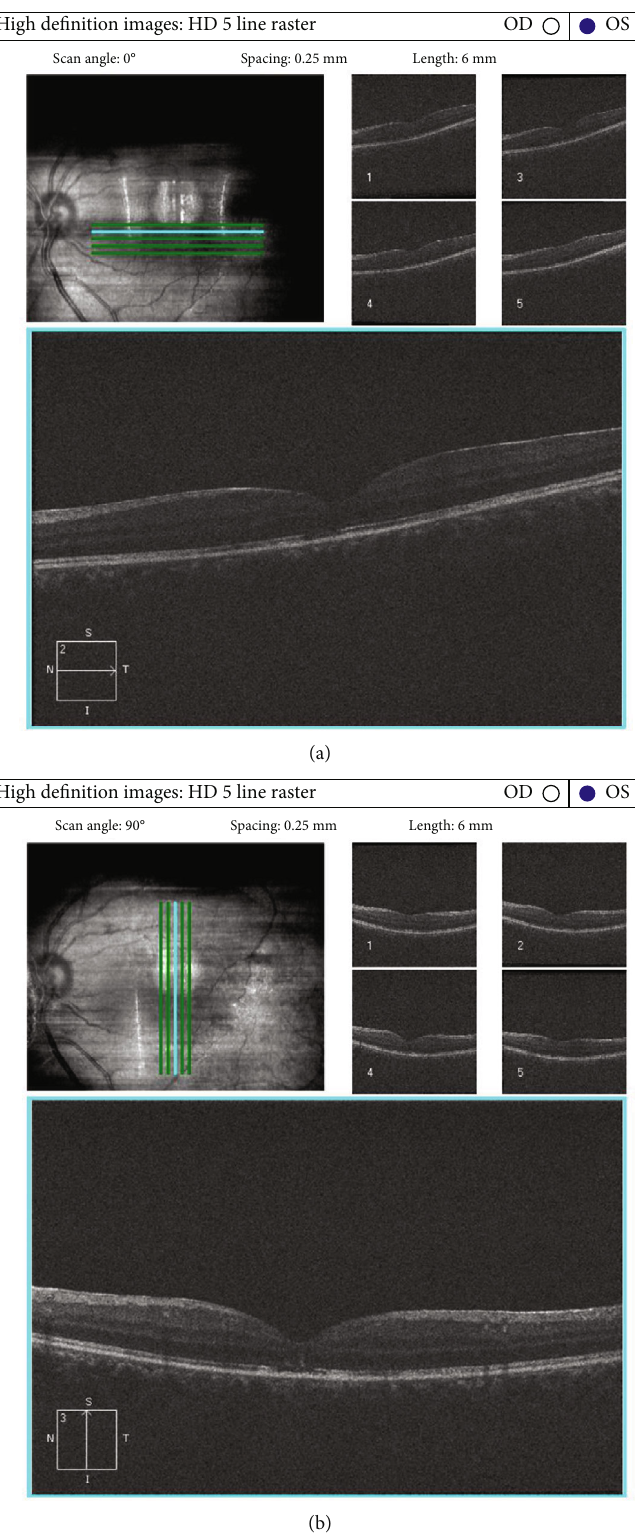
Figure 3: OCT horizontal and vertical HD raster scan showing closure of MH with improvement of microarchitecture of the